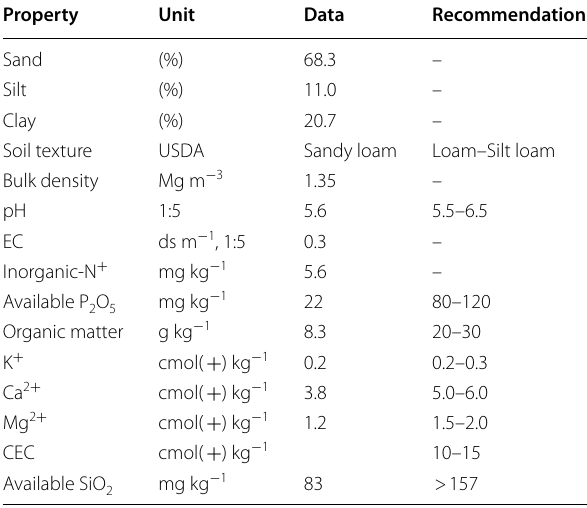
Table 1 Physicochemical properties of soil used in this study